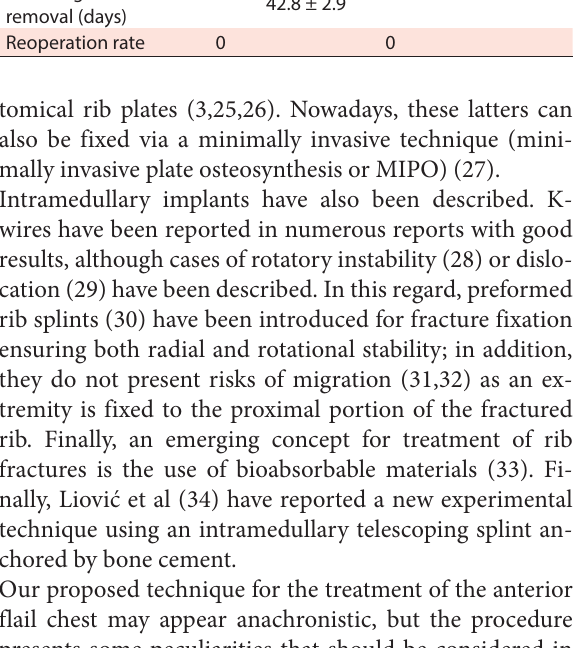
Figure 3. Early postoperative changes in respiratory and metabolic parameters in flail chest patients.